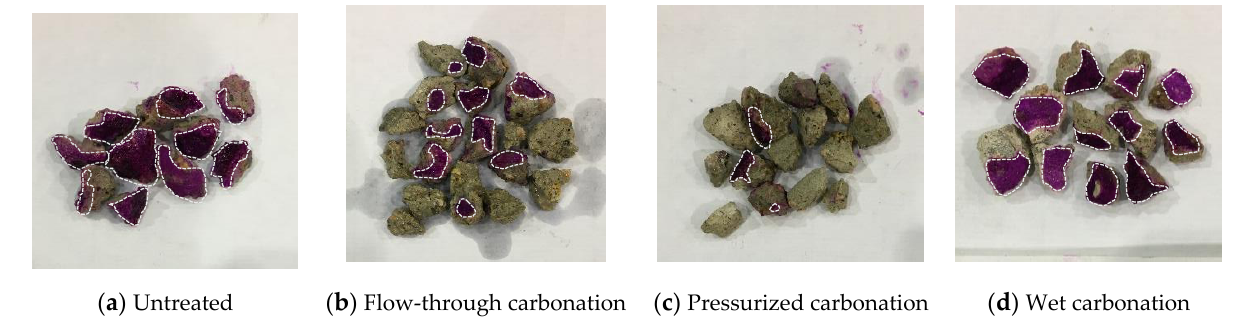
Figure 3. Untreated and carbonated RCAs after spraying phenolphthalein solution.